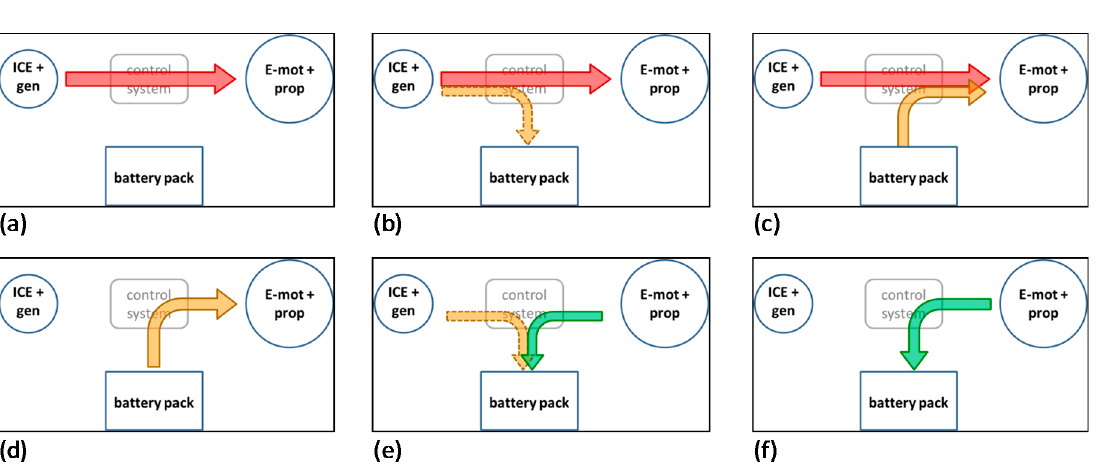
Figure 2. Some possible power flows in the serial hybrid electric propulsion system: ( a ) The ICE with the generator powers the propeller electrical motor directly; ( b ) the same as (a) plus the ICE with the generator charges the battery pack; ( c ) both the ICE with the generator and the battery pack power the propeller electrical motor; ( d ) the battery pack solely powers the propeller electrical motor; ( e ) the battery pack is charged by the propeller electrical motor and by the ICE with the generator in the regeneration regime; ( f ) the battery pack is charged solely by the propeller electrical motor in the regeneration regime.